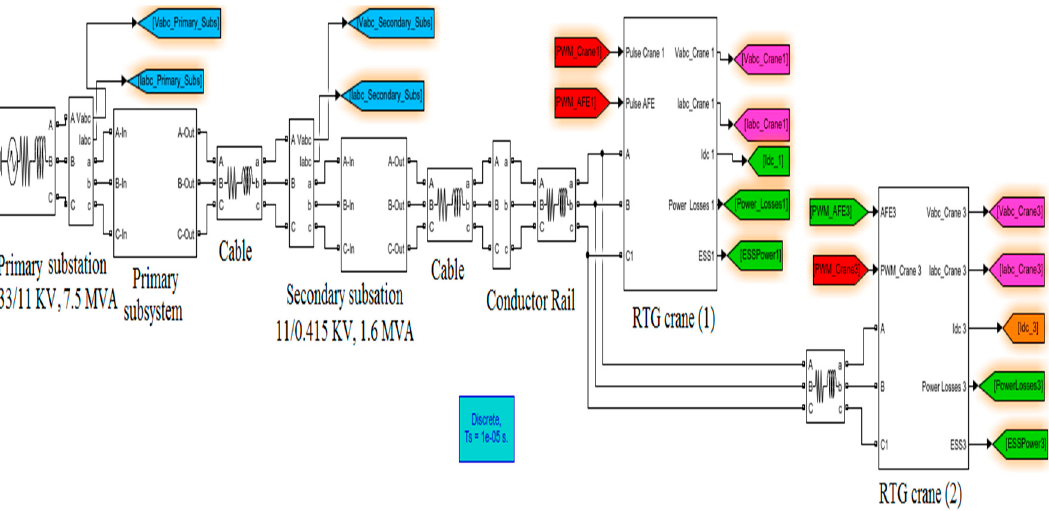
Figure 4. Simulink model of a network of two RTG cranes.